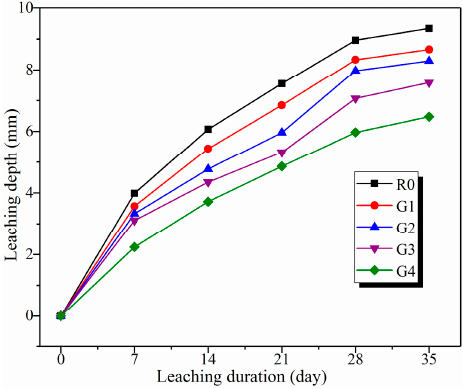
Figure 6. Linear fitting of the leaching depth of the samples in relation to the square root of the leaching duration. Note: the equations of the fitting curves of R0, G1, G2, G3, and G4 are y=1.642x– 0.083, y=1.524x–0.156, y=1.438x–0.263, y=1.292x–0.204, and